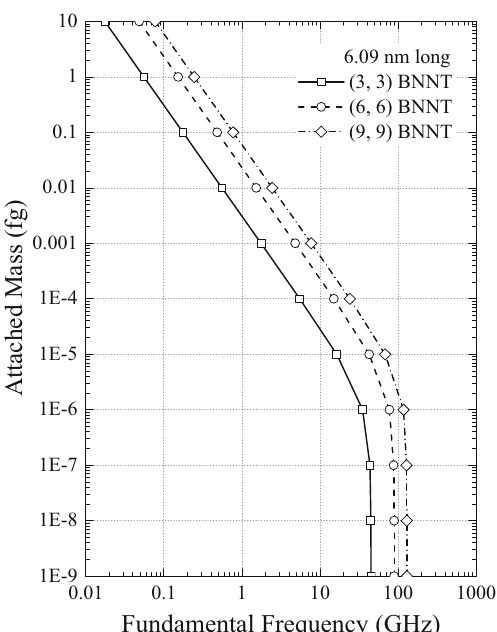
Figure 5: Resonant frequencies for ( 3,3 ) , ( 6,6 ) , and ( 9,9 ) cantilevered SW - BNNT with length 6.09nm for di ff erent attached masses.